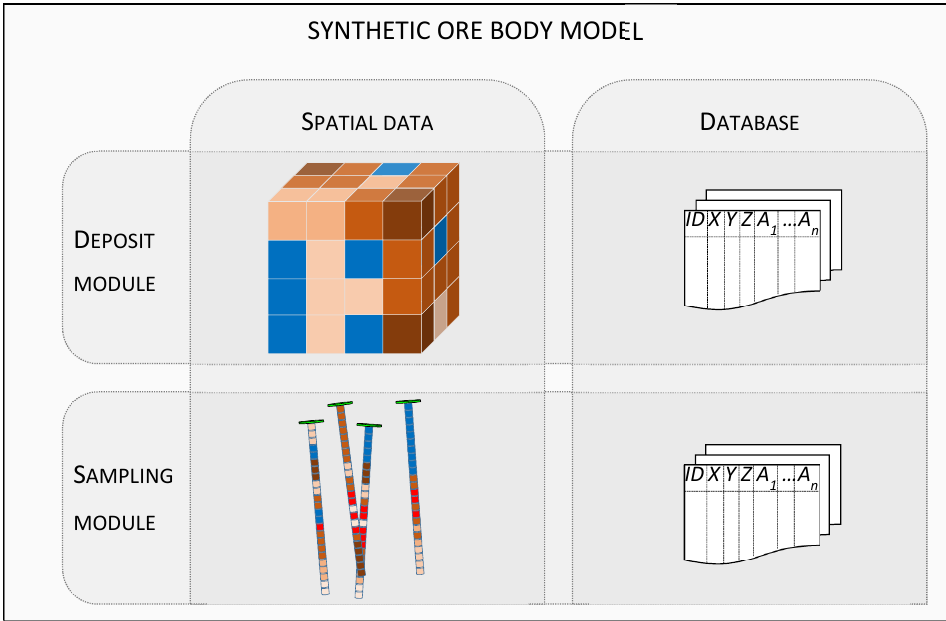
Figure 1. Structure of the synthetic ore body model.